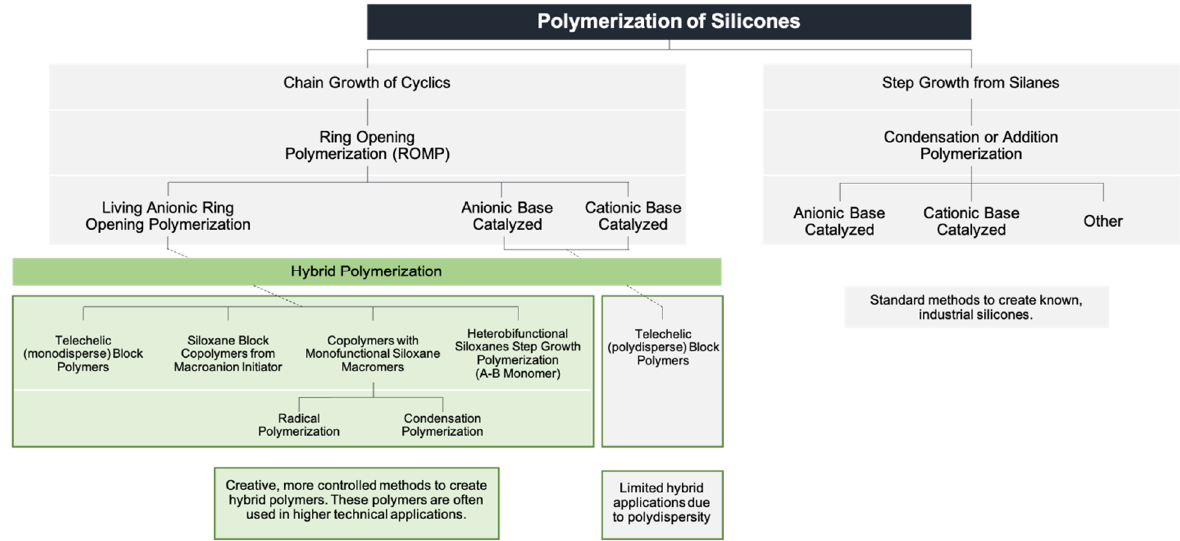
Figure 1. Synthetic methods for preparation of siloxane and siloxane-hybrid polymers.